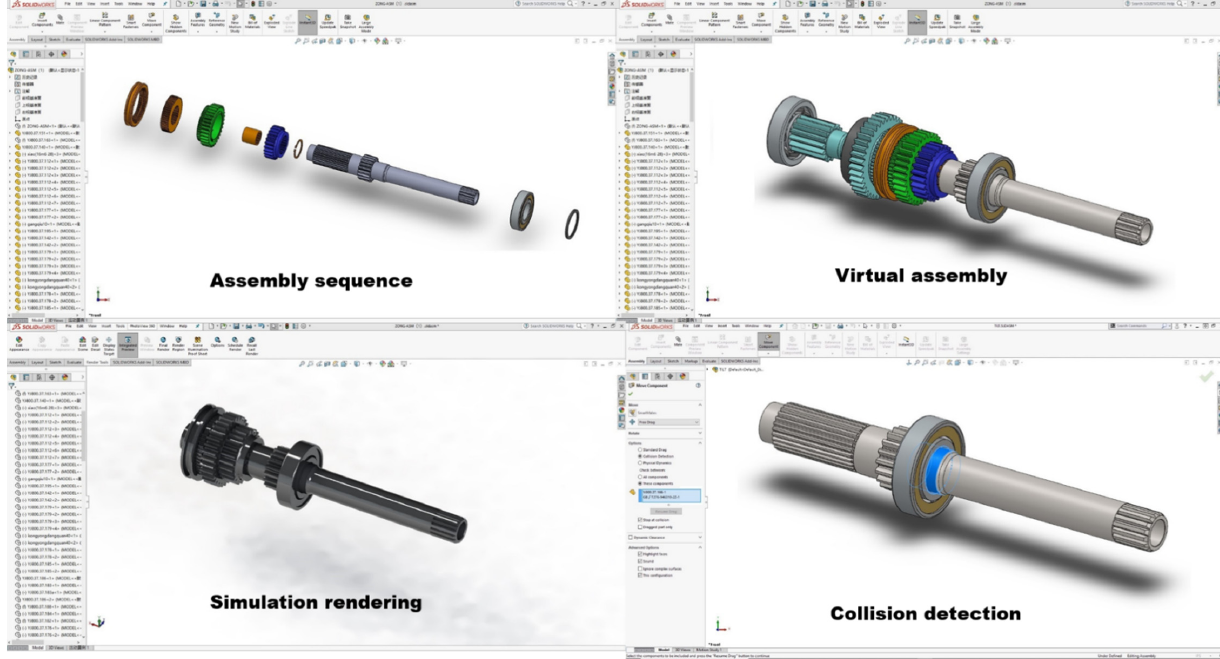
Figure 22. Screenshot of the operation process.